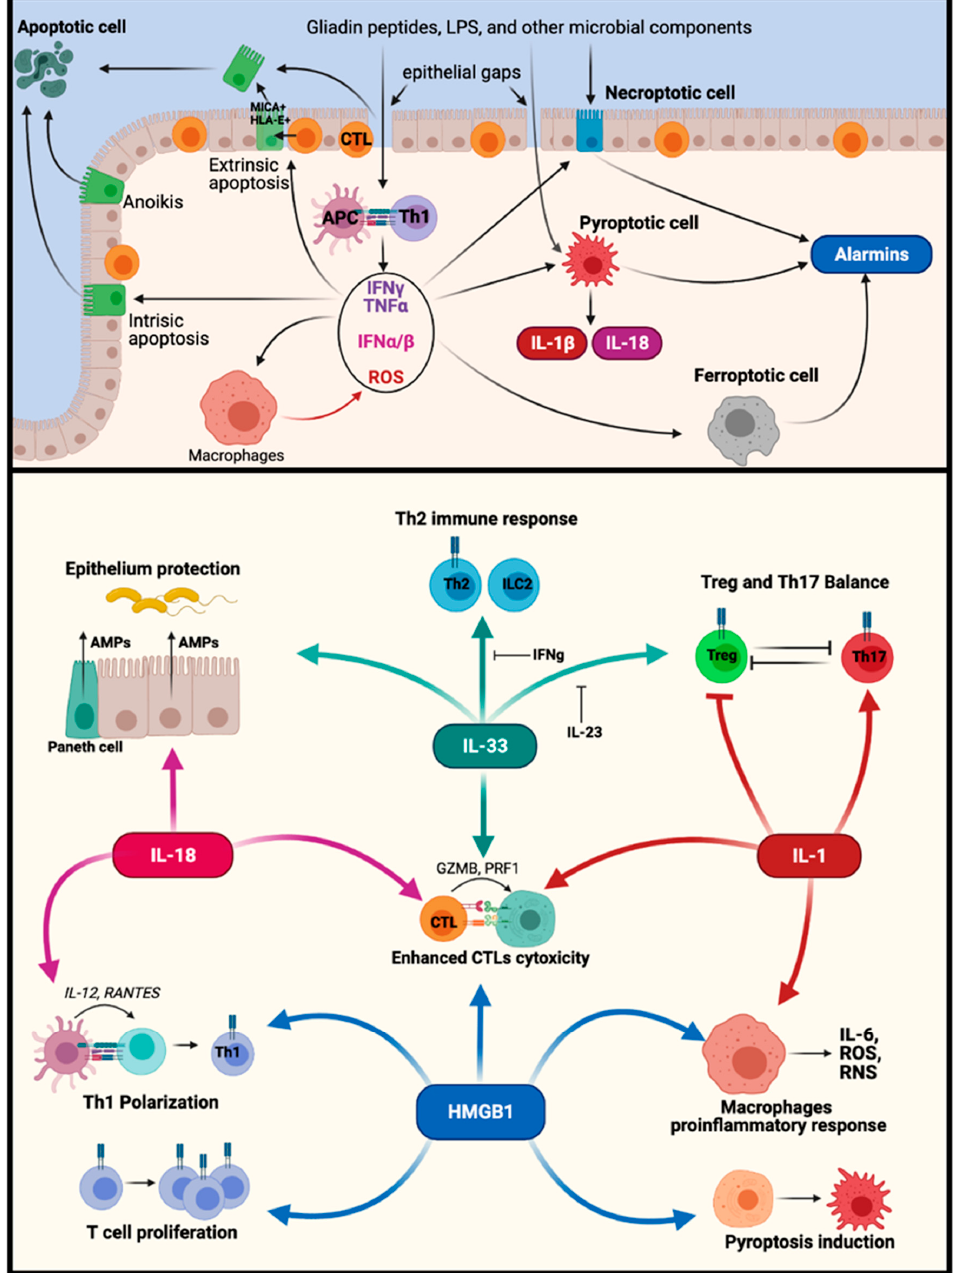
Figure 4. A new complex hypothetic scenario for CD pathology. ( Top Image ): Coexistence of different PCD in CD mucosae. Conclusions. Extrinsic apoptosis is primarily triggered by NK ‐ like CTLs in the epithelium and stressed target cells (MICA + , HLA ‐ E + ) in the epithelial compartment. At the same time, inflammatory cytokines released by Th1, CTLs (IFN γ ,